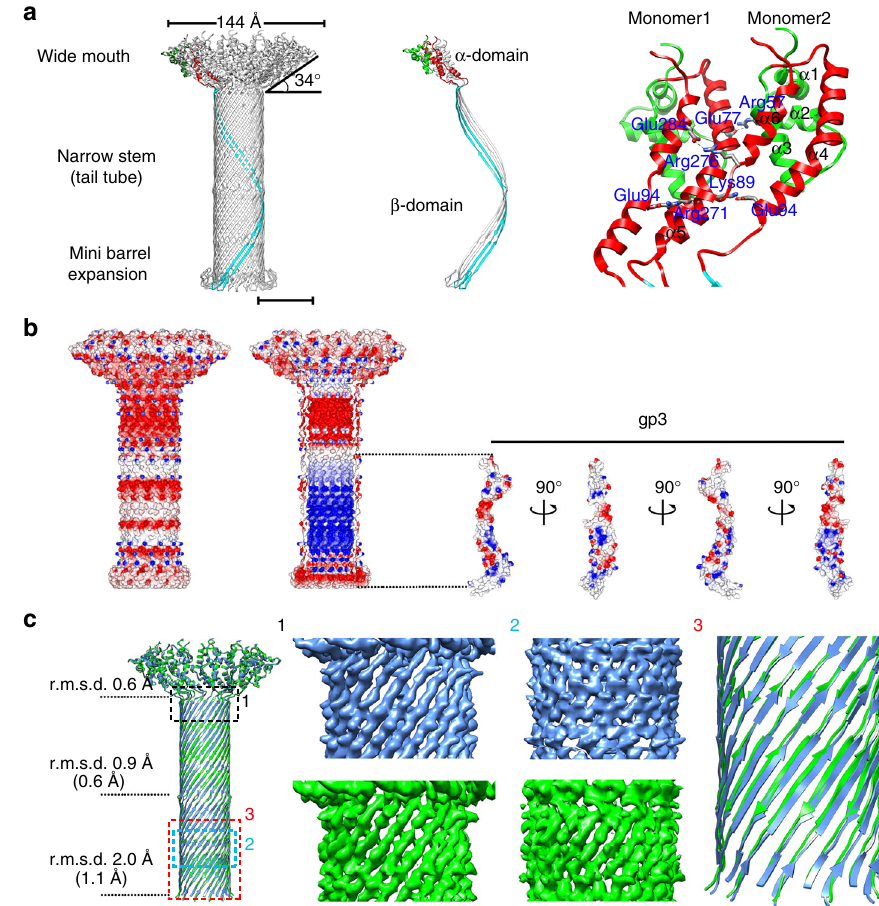
Fig. 7 Structure of the lower collar. a Left: Ribbon diagrams showing the lower collar assembly; middle: ribbon diagrams showing two gp11 monomers of the lower collar assembly. One of the two monomers is colored according to its domains (gp11- α 1 – 3: green, gp11- α 4 – 6: red, β -domain: cyan), while the other gp11 monomer is colored gray; right: a zoom-in showing salt bridges in between two gp11 monomers at the wide mouth region of the funnel-shaped lower collar. The scale bar represents 5 nm. b Surface electrostatic potential of the lower collar and the terminal protein gp3. Negative and positive electrostatic potentials are colored red and blue, respectively. Left: outer surface electrostatic potential of the lower collar; middle and right: inner surface electrostatic potential of the lower collar and outer surface electrostatic potential of the terminal protein gp3. c Left: ribbon diagrams showing gp11 α -domain-based structural superimpositions of the mature virion lower collar (blue) and the genome emptied virion lower collar (green). R.m.s.d.s for different portions of the lower collar were calculated and shown at the left side of the superimposition. The r.m.s.d.s shown in the parentheses were calculated from the structural superimpositions by using the upper or the bottom portion of the β -domain; middle: representative densities of the upper and the bottom portions of the β -domains; right: a zoom-in showing the contraction of the lower collar upon genome